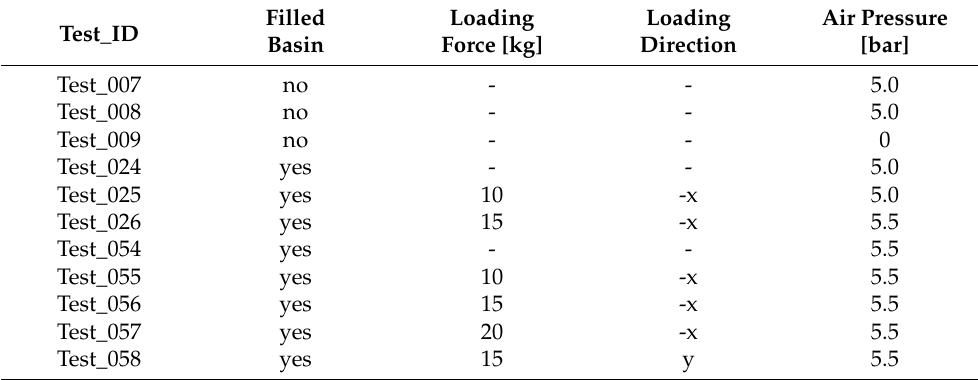
Table 3. Overview of the friction characterization tests.